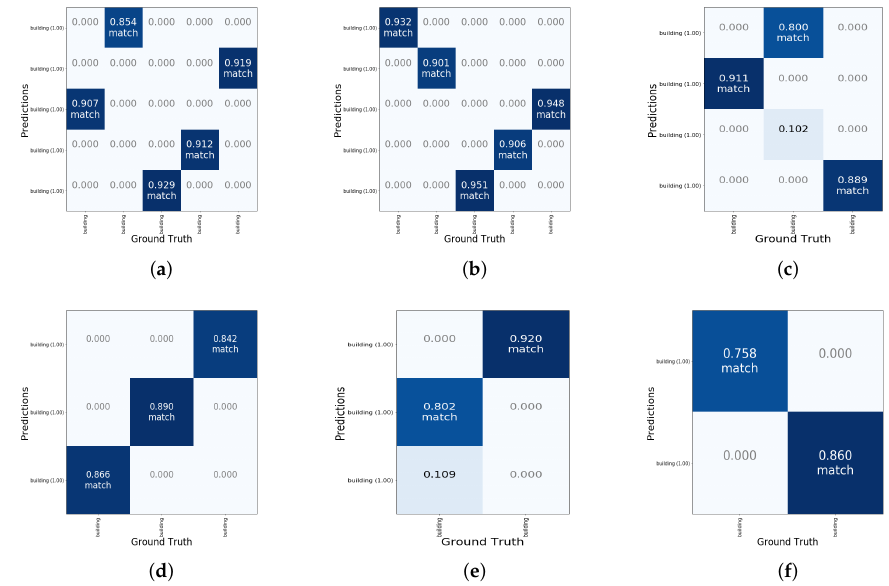
Figure 5. Grid of ground truth objects and their